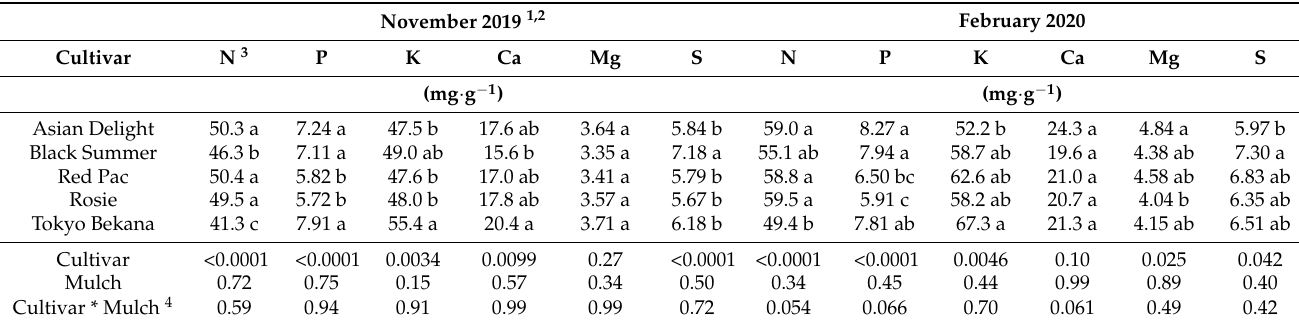
1 Different lower case letters suggest significant difference among means within a column indicated by the Tukey’s HSD test at p ≤ 0.05. 2 Means for a certain cultivar were obtained by averaging data from all four mulch types. 3 N = nitrogen; P = phosphorus; K = potassium; Ca = calcium; Mg = magnesium; S = sulfur. 4 * suggests interaction between cultivar and